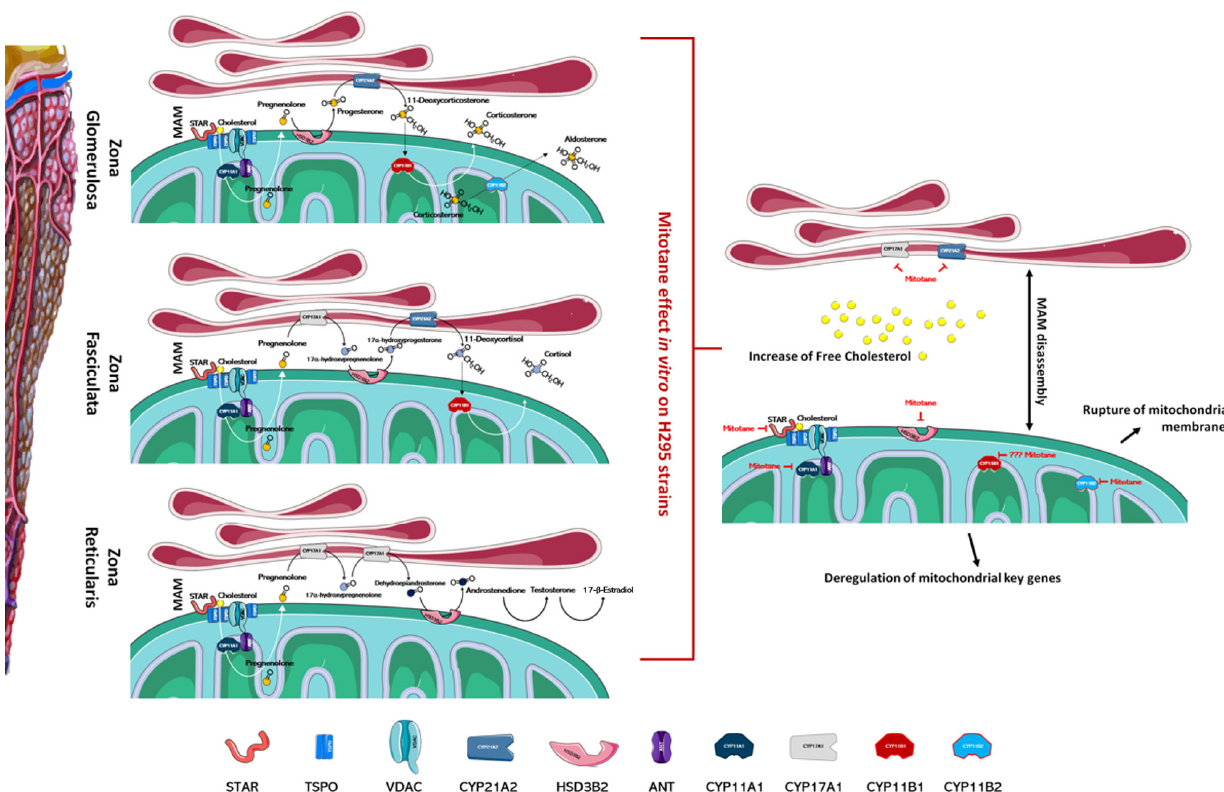
Figure 1. Mitotane impairs the function of the adrenal cortex. In the left part of the figure, the different zones of the adrenal cortex are schematized; the main enzymes involved in the biosynthesis of steroid hormones are also indicated. As depicted in the right part of figure, mitotane action, identified by in vitro experiments, involves several mechanisms ranging from the deregulation of mitochondrial key genes at a transcriptional and functional level, to the MAMs dissociation, the rupture of mitochondrial membranes, and altered cholesterol transports/metabolism. Mitotane action for each enzyme is indicated by a red mark. Figures have been created modifying an image set from Servier Medical Art (SMART) http://smart.servier.com/ (19 July 2021).